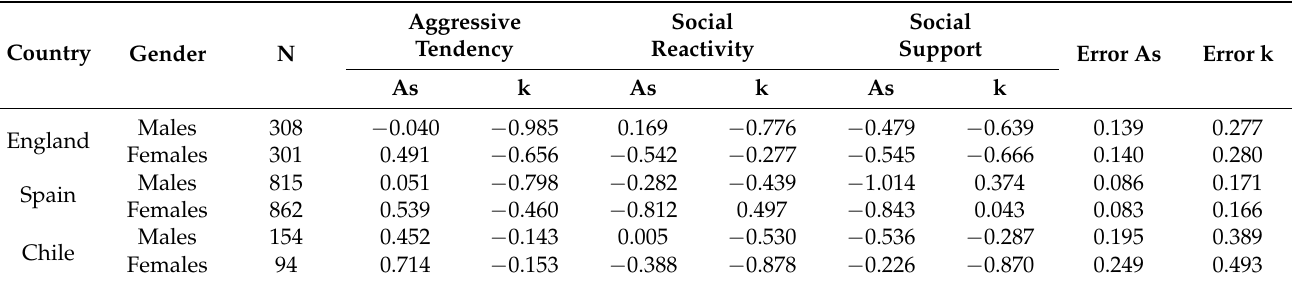
Table 2. Skewness (As) and kurtosis (k)